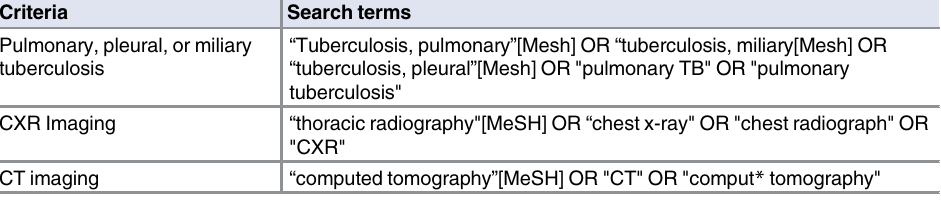
Table 1. Template for literature search: Pulmonary, pleural or military tuberculosis AND [CXR imaging OR CT imaging].